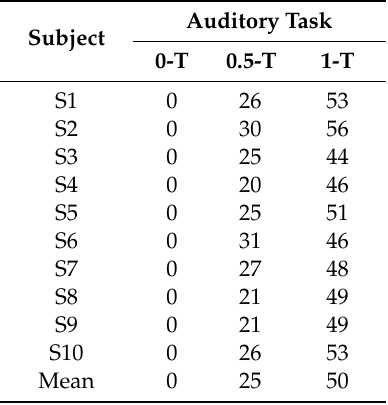
Table 3. The number of “De” the subjects count.